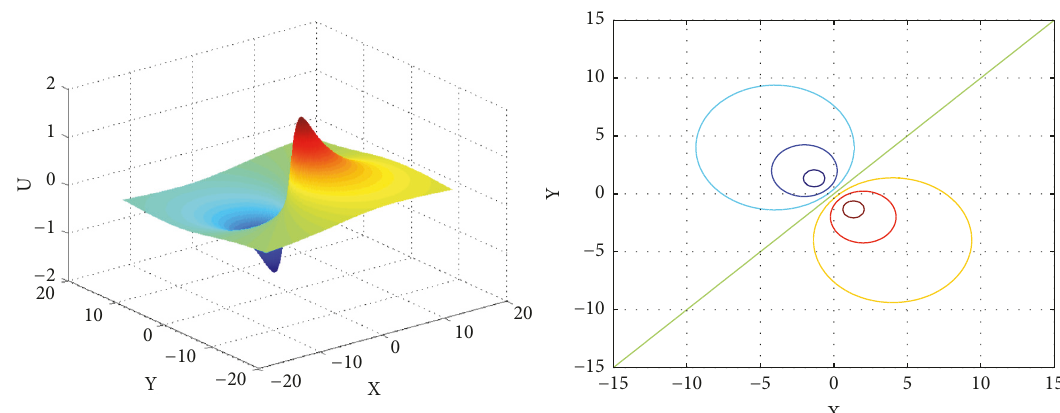
Figure 3: The 3D plot of lump (23) and the corresponding contour